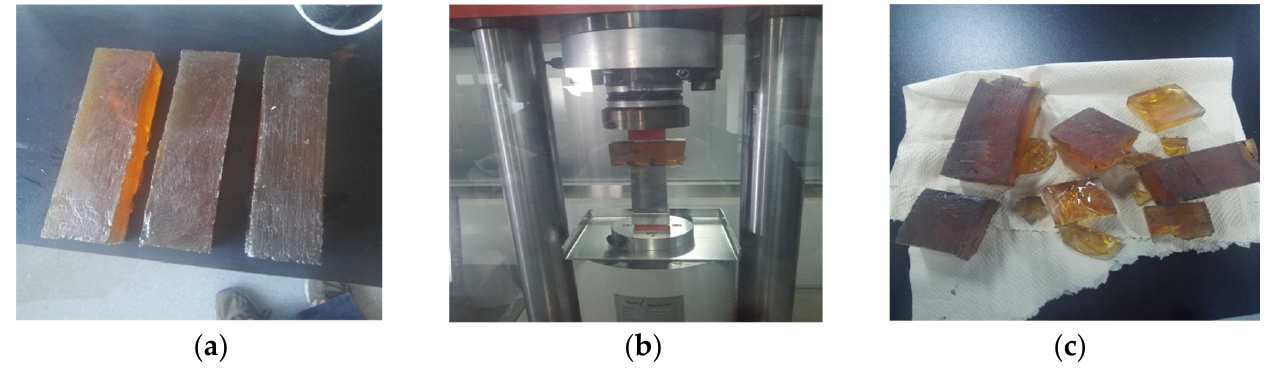
Figure 3. Sealant compressive strength tests. ( a ) Sealant specimens before the test. ( b ) Tensile test equipment. ( c ) Sealant specimens after the test.